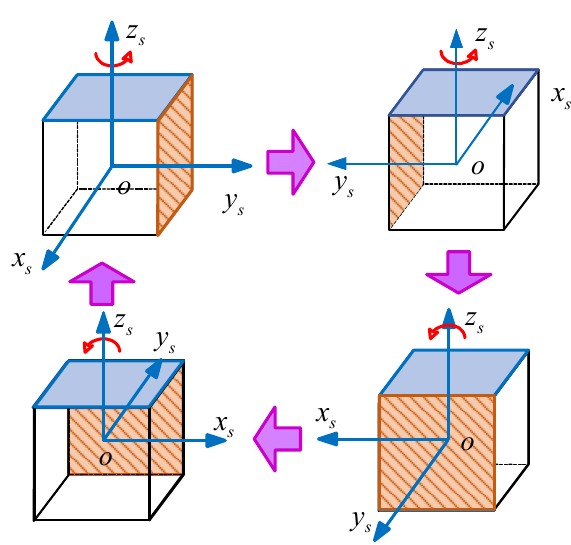
Figure 11. The rotation scheme of the single-axis RSINS.